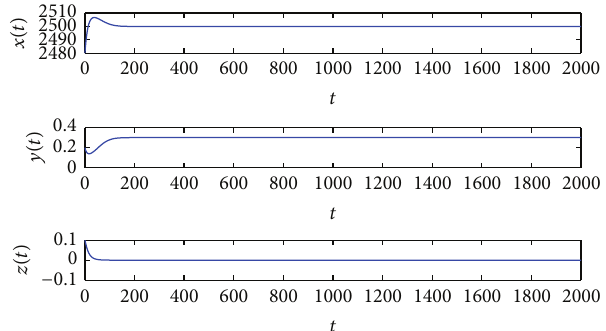
Figure 2: Local asymptotic stability of the immune-exhausted equilibrium 𝐸 1